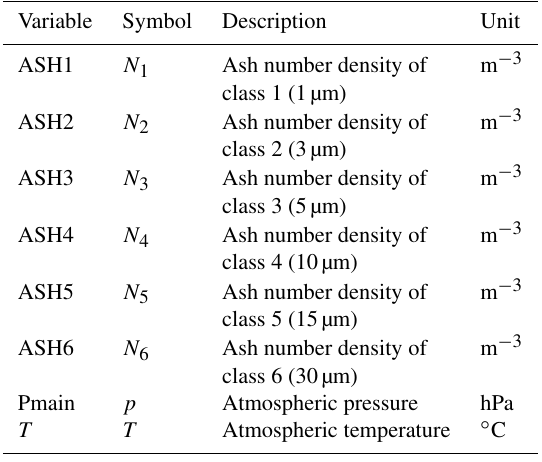
Table 1. Output variables of COSMO-ART used by the forward operator for the selected case